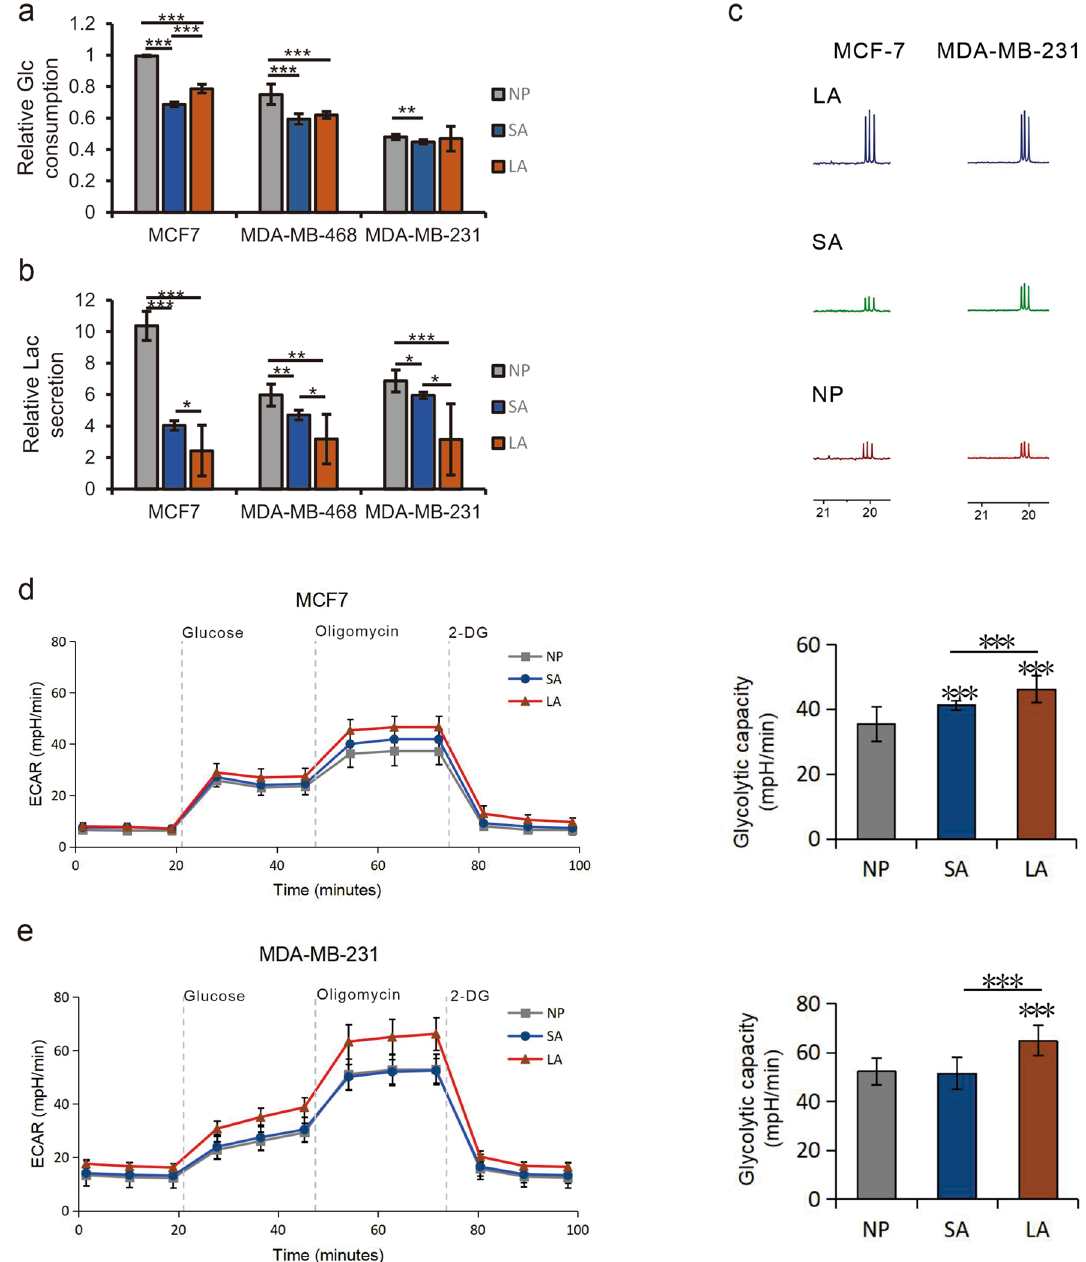
Figure 2. Acidosis can decrease the glycolysis in cancer cells. Glucose consumption ( a ) and lactate excretion ( b ) of breast cancer cells under different culture conditions. 13 C NMR spectra of labeled lactic acid in MCF-7 and MDA-MB-231 cell lines ( c ). The MCF7 ( d ) and MDA-MB-231 ( e ) cells were detected for ECAR after treated for 48 h. Values are expressed as mean ± SD. * P < 0.05, ** P < 0.01, *** P < 0.001 by unpaired Student’s test, n ≥